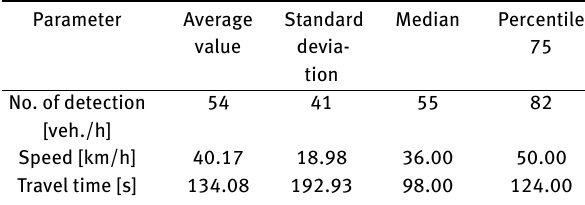
Figure 5. Data set description is presented in Table